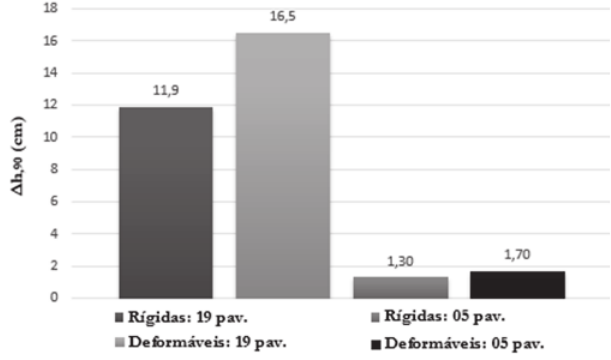
Figura 10 Modelo de Ferreira, El Debs e Elliot [1]: deslocamento horizontal da estrutura com